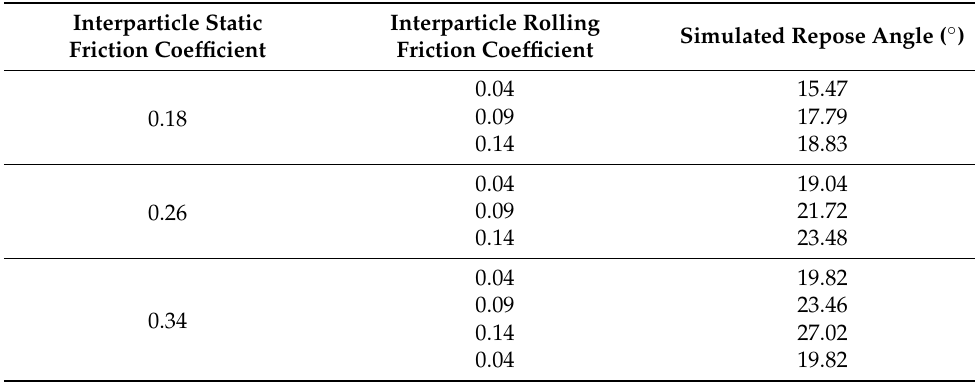
Table 4. Simulation test results of the repose